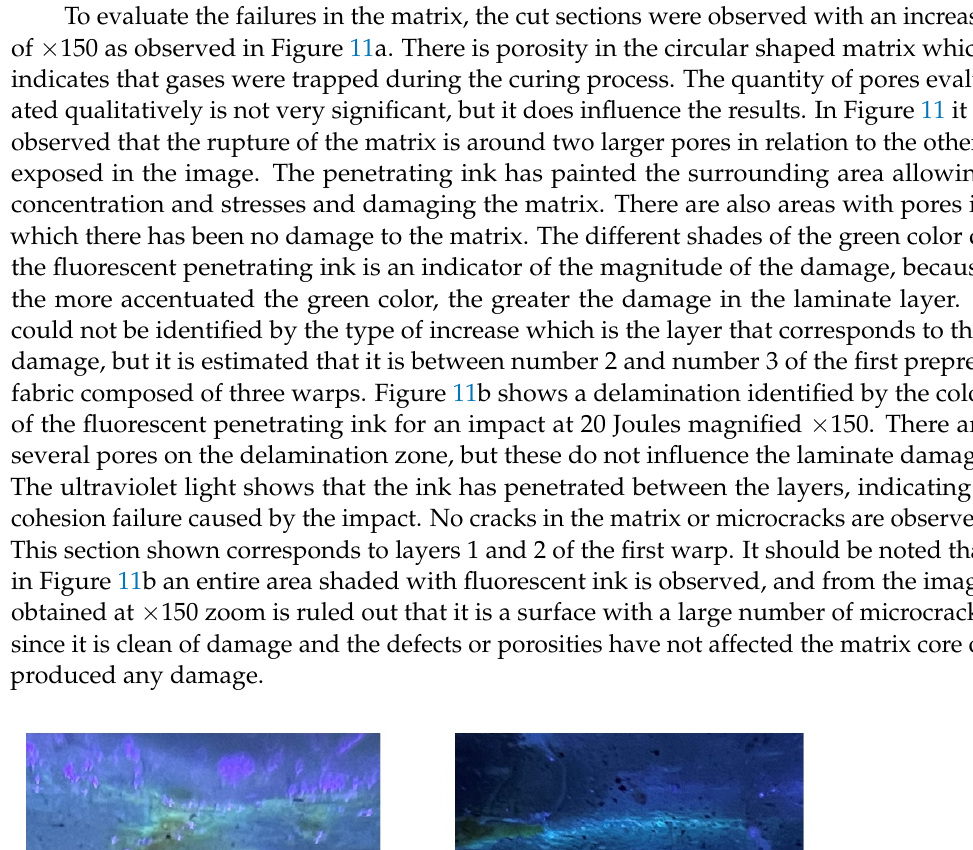
Figure 12. Acceleration profile (m/s 2 ) of the panels during deformation for impacts of 10, 20, 30 and 40 joules. When the impact on the laminate occurs at 10 joules, the configuration of the laminate due to its orthotropic means that the greatest damages tested by the gravitometer are ori- ented over the same area, showing a kind of continuity as seen in Figure 13a. The rupture of the matrix (observation given by the type of spots under the fluorescent light of this area without horizontal lines) follows the orientation of the layers at the indicated points 1, 2 and 3 which corresponds to a factory prepreg sheet. For this reason, a jump is observed in the rupture of the matrix from layer 3 to 4, in which the adhesion of the fabrics is acting, which was observed in the curing time and which was acceptable. The group of sheets 4, 5 and 6 are broken mainly following the same trend of the previous prepreg group. In the